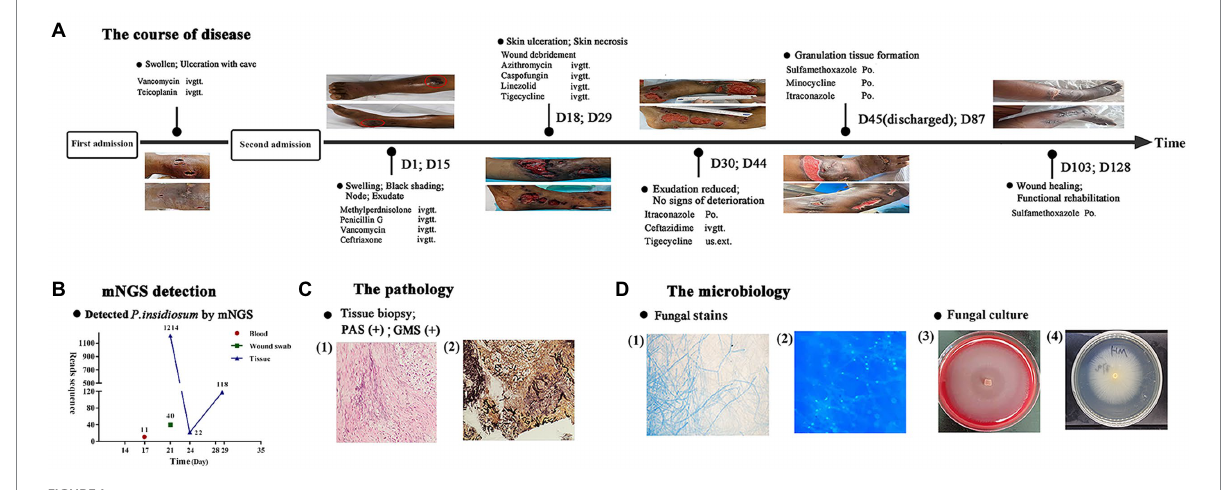
FIGURE 1 Flowchart of the diagnosis and treatment of the patient. (A) The course of disease over time. (B) The sequencing reads of mNGS. (C) Histopathology of the skin ulcer: (1) periodic acid-Schiff staining, (2) Gomori methenamine silver staining. (D) Staining of cultured hyphae: (1) gram staining, (2) immunofluorescence staining and images of fungal culture: (3) blood agar medium, (4) potato dextrose agar